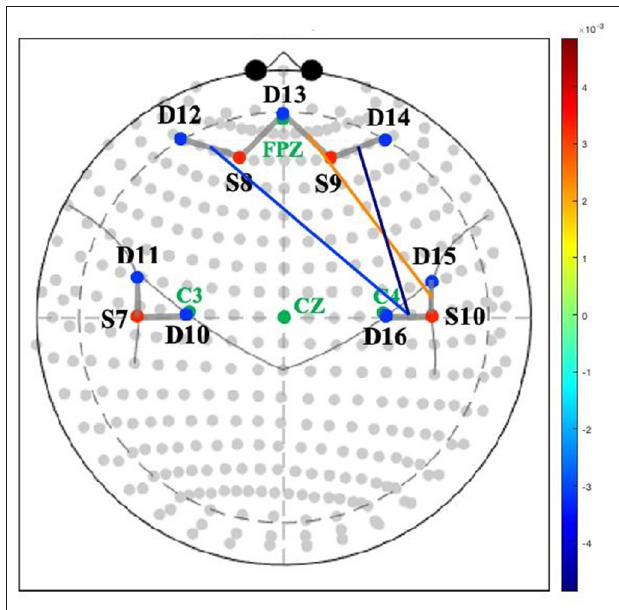
FIGURE 1 | Association between maternal depressive symptoms and neural connectivity during mother-infant play. Colored lines represent magnitude ( t -values) of connectivity between channels. S, source; D, detector.